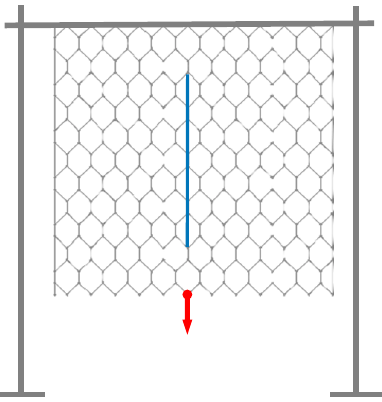
Figure 3. Experimental test setup—first session: the OF cable is glued at double-twisted sections. Water 2020 , 12 , x FOR PEER REVIEW